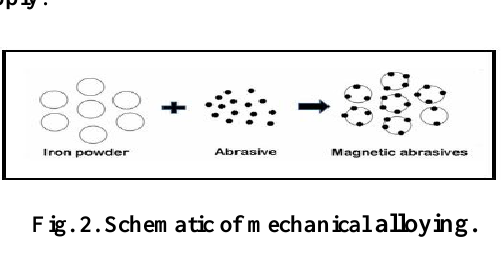
Fig. 1. Photograp of magnetic abrasive machine supply .